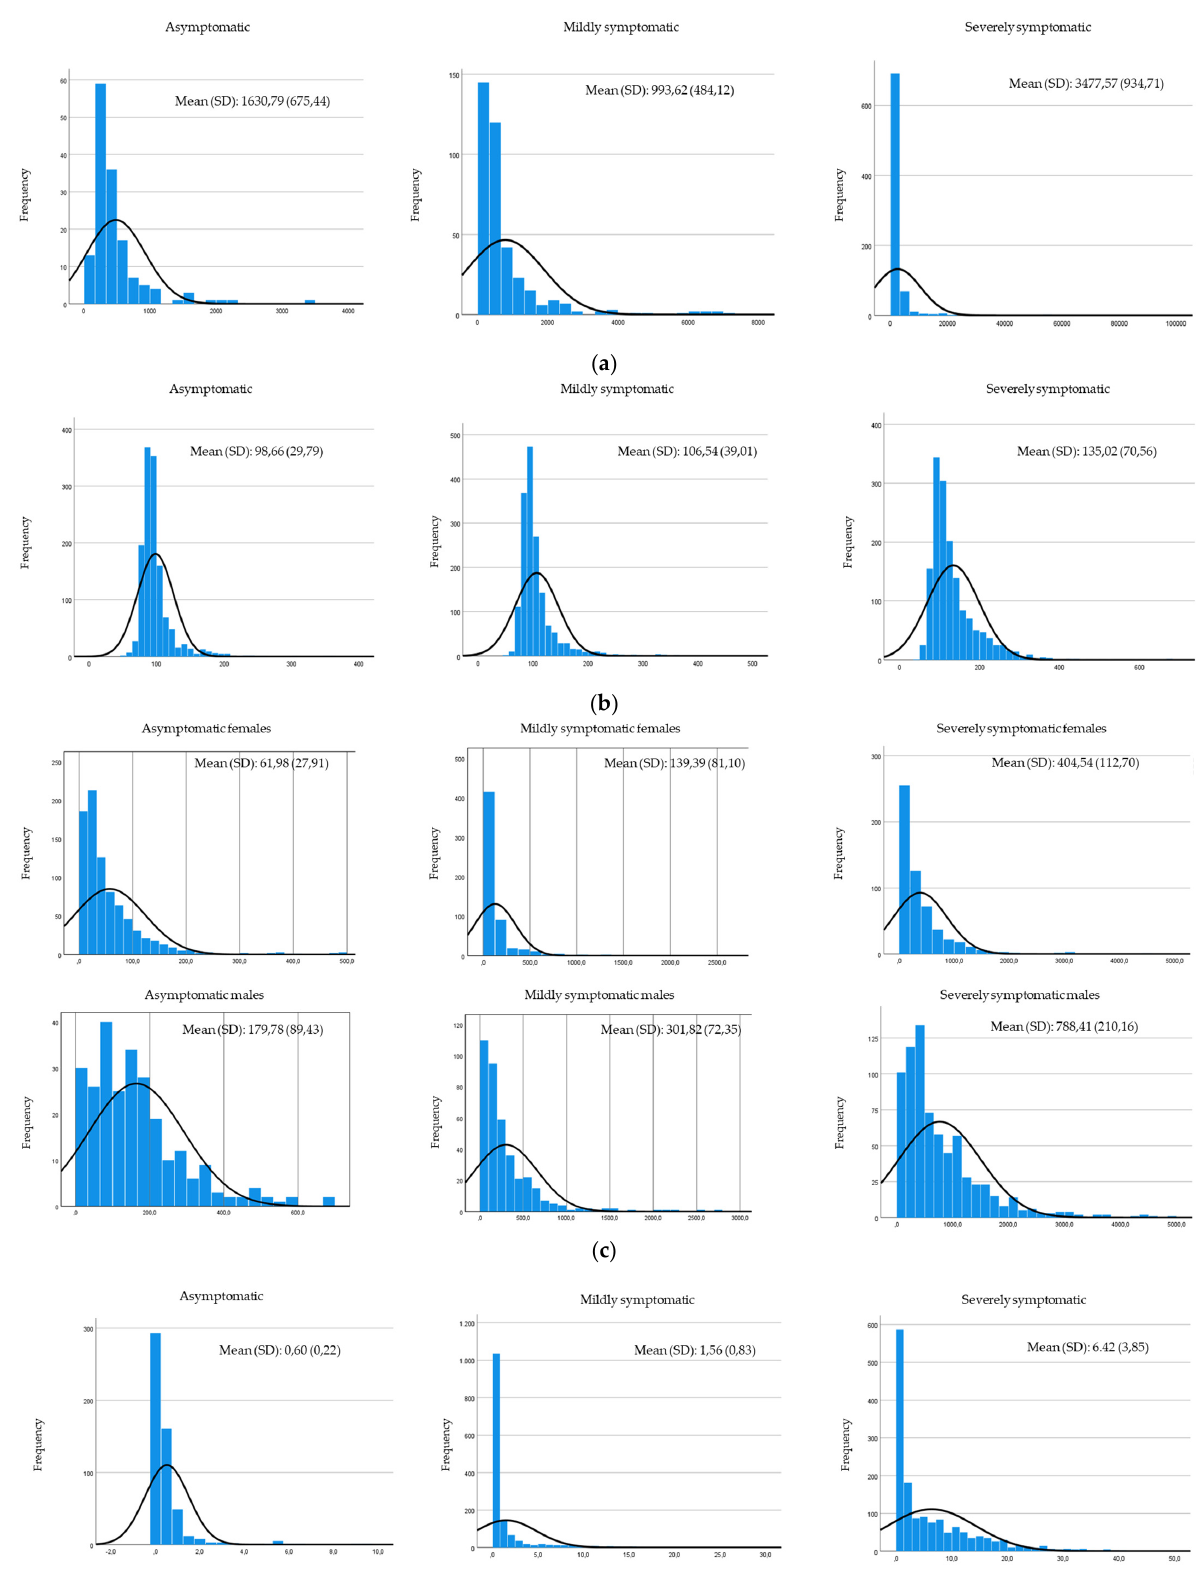
Figure 1. Comparison of the range clinical variables: ( a ) range of D-dimer values, ( b ) range of glucose values, ( c ) range of serum ferritin values, ( d ) range of c-reactive protein values. When analysing the alteration level of the analytical parameters in relation to the symptoms presented by the COVID-19 positive patients (Table 3), it was observed that the highest percentage of severe alterations of the values for D-dimer and C-reactive protein were seen in patients with severe symptoms (D-dimer: 44.7%; C-reactive protein: 46.5%). Asymptomatic patients and those with mild symptoms mostly presented normal values for both D-dimer and C-reactive protein. Hyperglycaemia was presented in 38.8% of the patients with severe symptoms, and 20.8% had mild alterations in blood glucose levels. Normal blood glucose levels were seen in 77.4% of the asymptomatic patients and 67.5% of those with mild symptoms. Altered serum ferritin levels were presented in 78% of the males with severe symp- toms and 69.4% of the females with severe symptoms. Serum ferritin values were mostly normal in both males and females with mild or asymptomatic symptoms. Table 3. Distribution of the alteration level of the analytical values in relation to the symptoms presented by the patient. Asymptomatic ( n = 1346)